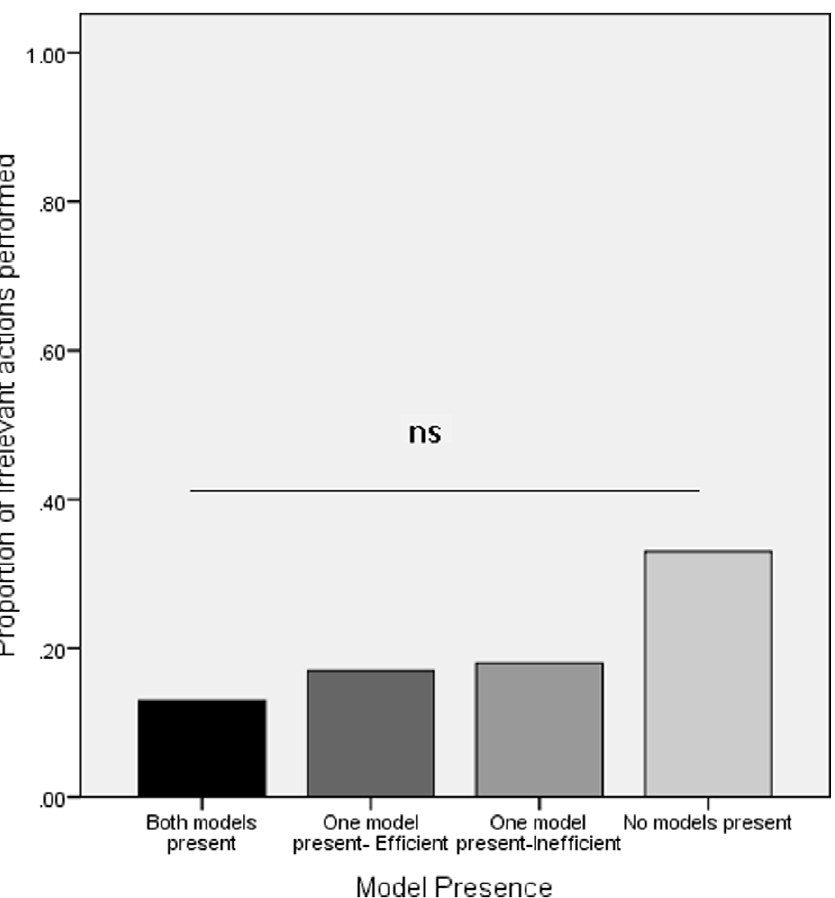
Figure 3. Proportion of irrelevant actions performed in the mixed strategy conditions of Experiment 1 as a function of model presence.